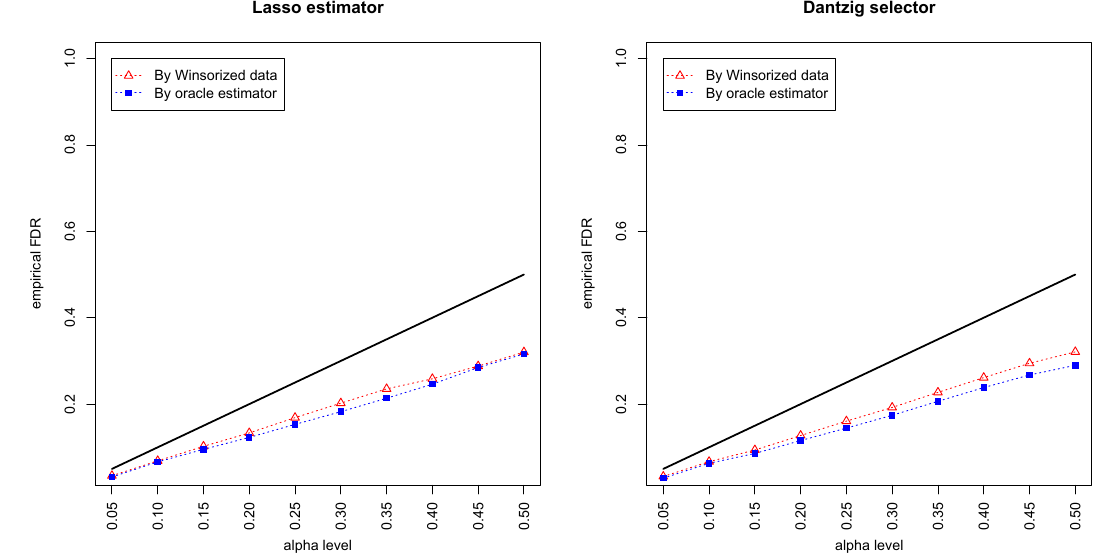
Figure 1. Empirical false discovery rates (eFDRs) by oracle data and Winsorized imputations under the band graph setting. The x -axis represents the desired FDR levels from 0.05 to 0.5, and the solid line is y = x